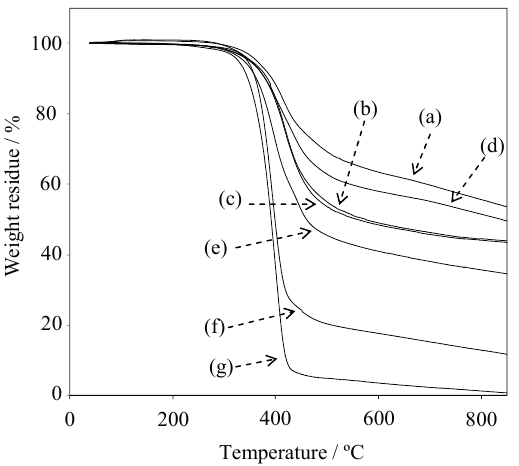
Figure 14. TGA curves of P(oligo(P-4va)) (a) and P(P-4va/BuA)s with 14 (b), 33 (c), 50 (d), 58 (e), and 63 (f) mol % of BuA